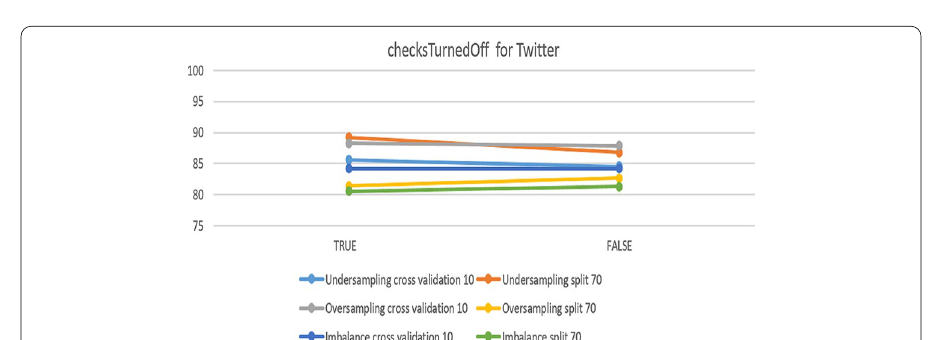
Fig. 21 The accuracy of checksTurnedOff for SVM in